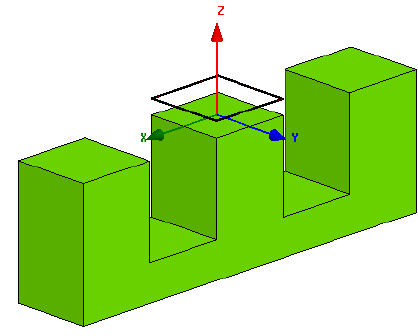
Figure 12. Simulation model of the numerical method.